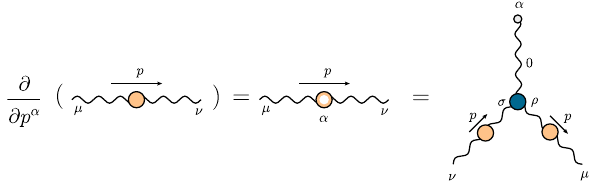
Fig. 8 Diagrammatic representation of the WI for the BQQ vertex, where the derivative of the gluon propagator can be identified as the insertion of a zero-momentum background gluon